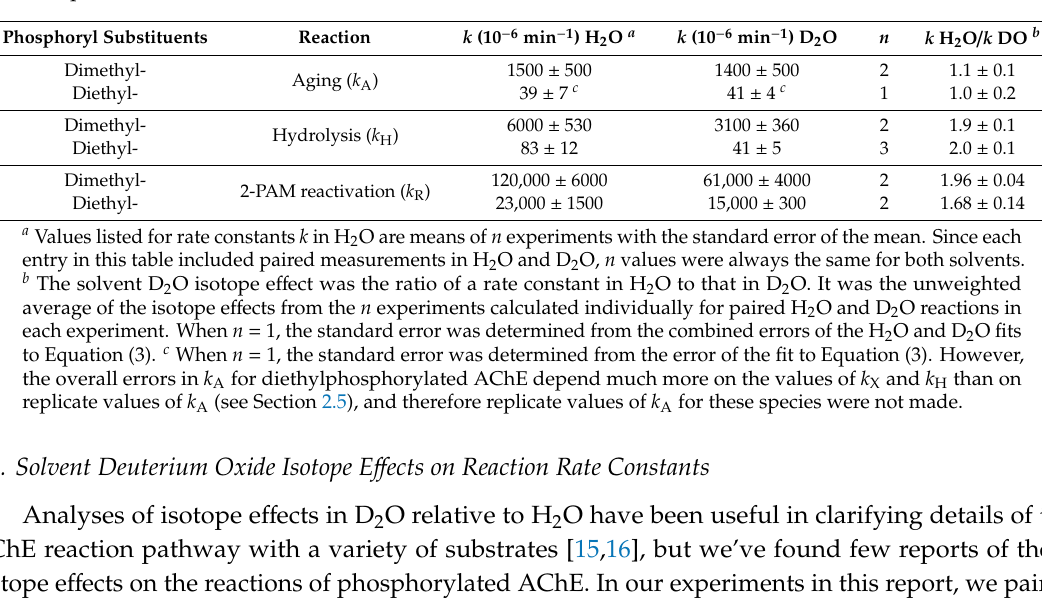
Table 1. Rate constants for reactions of organophosphorylated AChE and their solvent D 2 O isotope e ff